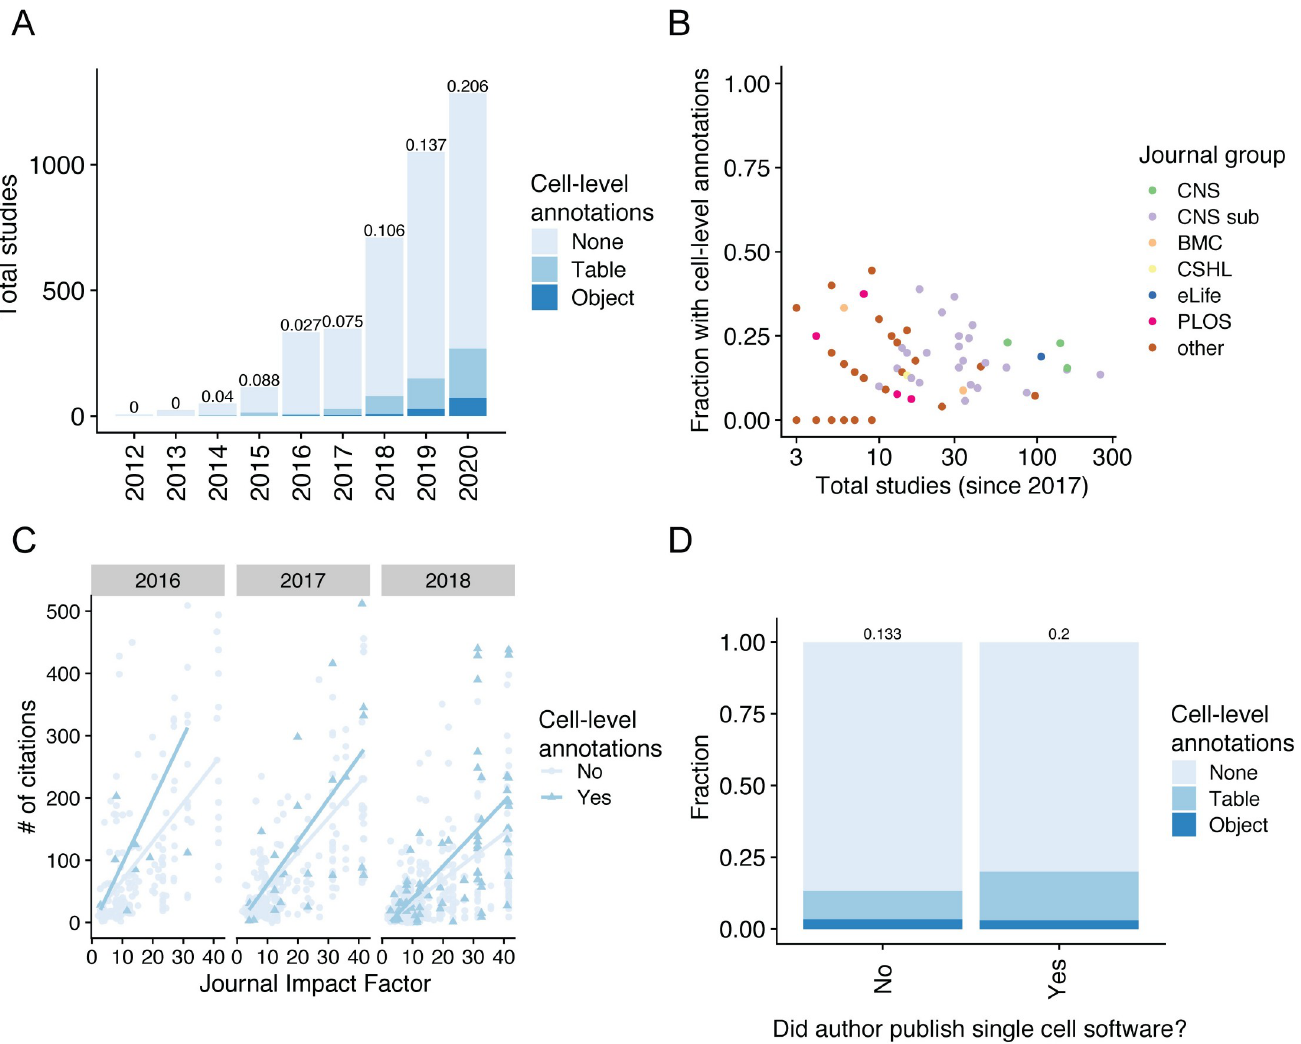
Fig 2. The majority of single-cell sequencing datasets archived on GEO do not have cell-level annotations. (A) Number of single-cell datasets in GEO annotated with the proportion that contain cell-level metadata per year, either as plain text tables or binary objects. (B) Fraction of studies published in each group of journals compared to the total number of studies published by each group. (C) Comparison of the number of citations for studies containing or lacking cell-level metadata in 2016, 2017, or 2018. (D) Fraction of studies, since 2017, containing cell-level annotations published by authors with a previous publication of a single cell–related software tool. The numerical data underlying plots may be found at https://github.com/rnabioco/someta/tree/master/inst/manuscript and http://doi.org/10.5281/ zenodo.4695069.